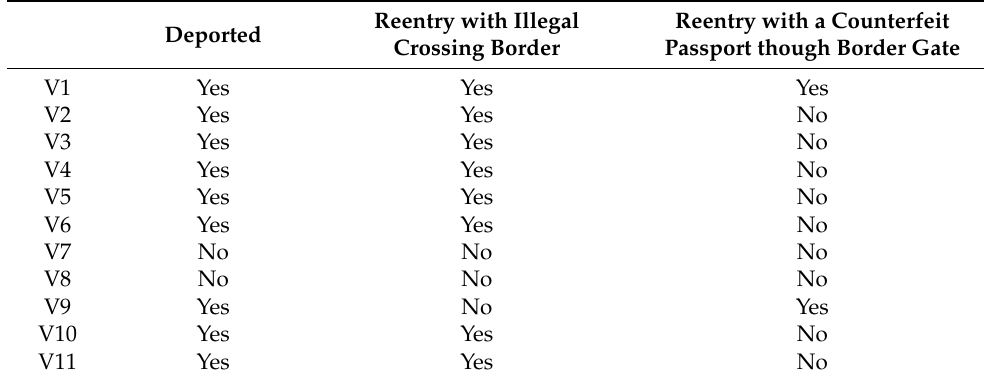
Table 4. The Traffickers Pointed Out by the